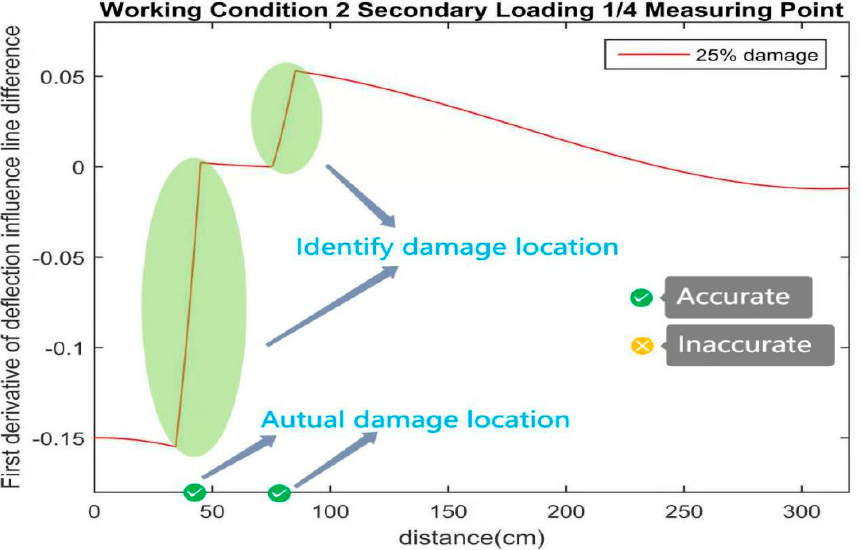
Figure 36. The first-order derivation of deflection influences line difference at 25/100 measuring point of the first span following work condition 5.